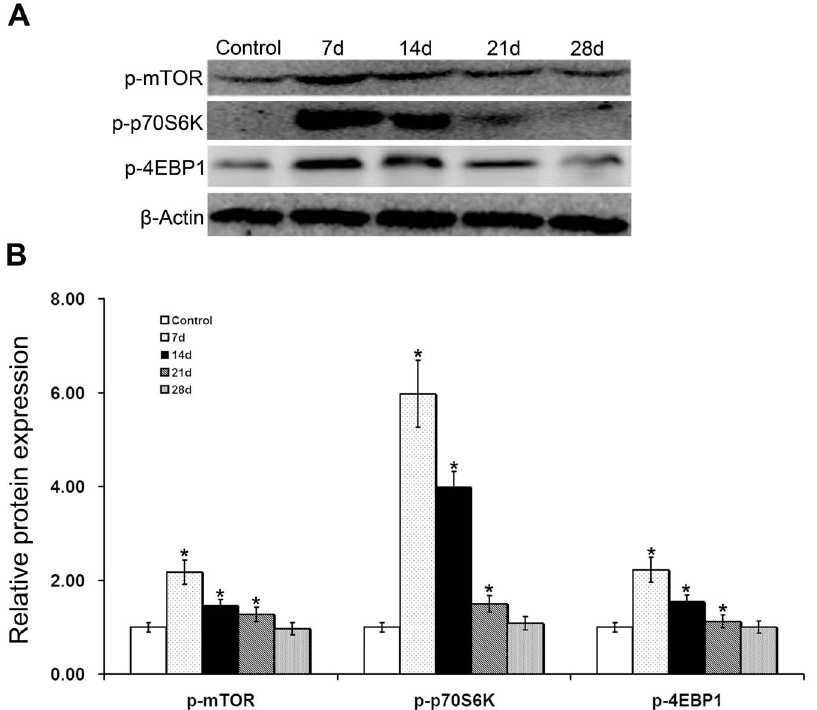
Figure 2. Activation of the mTOR signaling pathway in the glomeruli of PHN rats. Compared to control rats, the phosphorylation of mTOR, p70S6K, and 4EBP1 was enhanced in PHN rats on day 7 and continued to day 14, indicating that the mTOR signaling pathway was activated, * P , 0.05 vs Control.